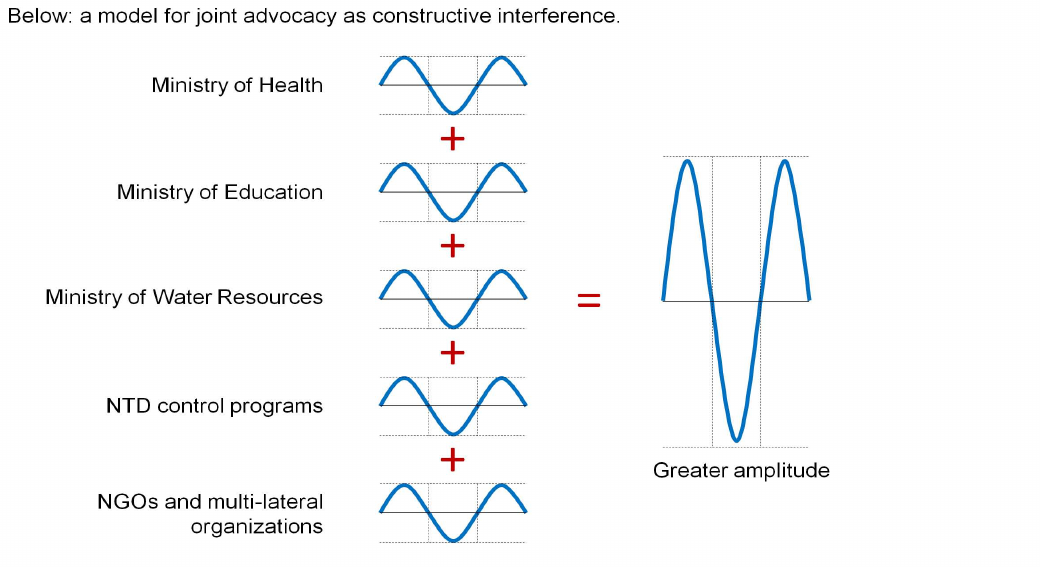
Figure 1. Joint advocacy and harmonized messaging between WASH and NTD sectors as ‘‘constructive interference.’’ Figure adapted from http:// www.physicsnet.co.uk [37].